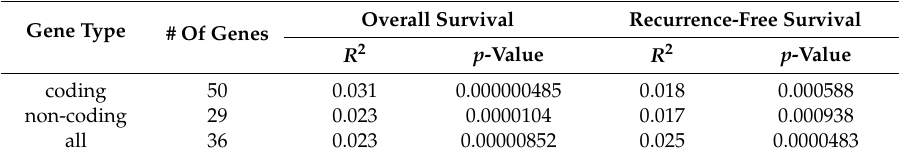
Table 4. Multivariate Cox regression survival analysis. Table 3. Evaluation of prognostic performance for risk scores from various gene signatures.